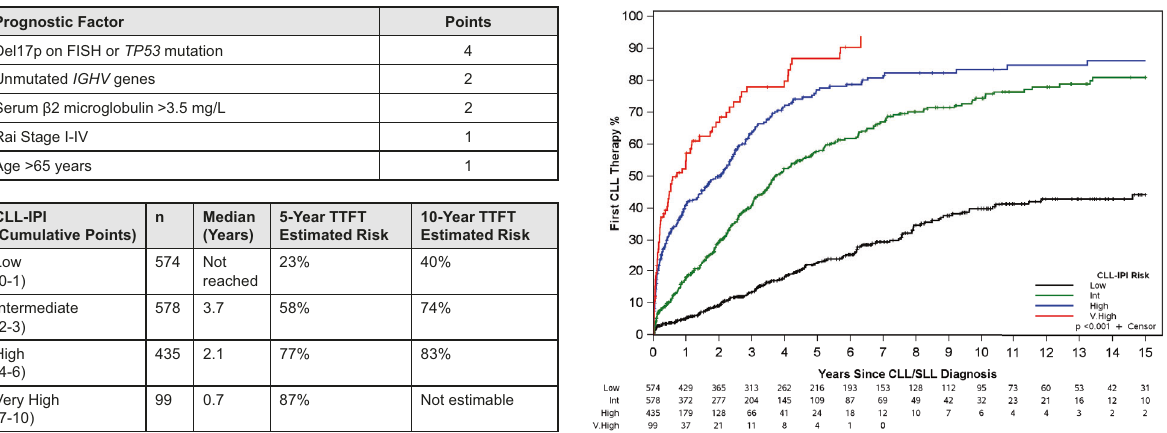
Fig. 2 The CLL-International Prognostic Index (CLL-IPI) and Time to First Therapy (TTFT) among newly diagnosed CLL patients seen at Mayo Clinic, Rochester, MN. Calculation of the CLL-IPI facilitates prognostic discussions regarding TTFT with newly diagnosed patients with CLL. FISH fl uorescence in situ hybridization, IGHV immunoglobulin heavy chain gene, TTFT time to fi rst